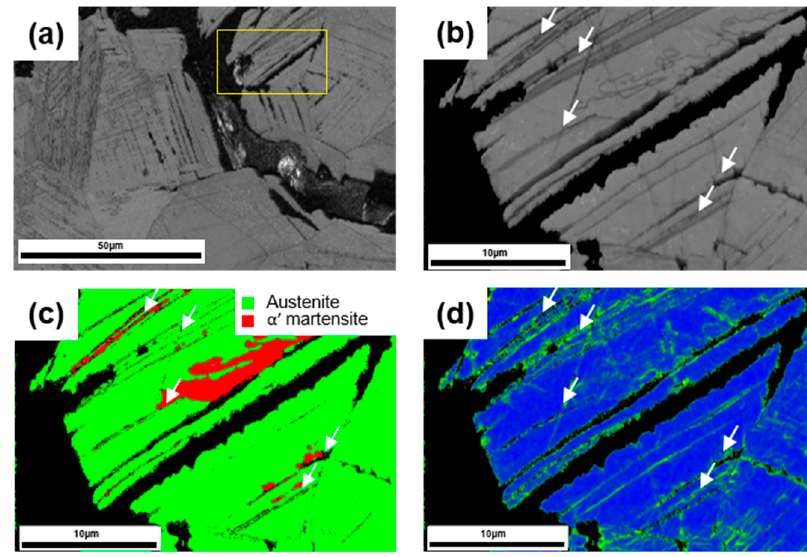
Figure 9. ( a ) Image quality map cropped in Figure 6a, ( b – d ) image quality map and phase map and KAM obtained from yellow rectangle in ( a ), respectively, and white arrows indicate branched cracks.